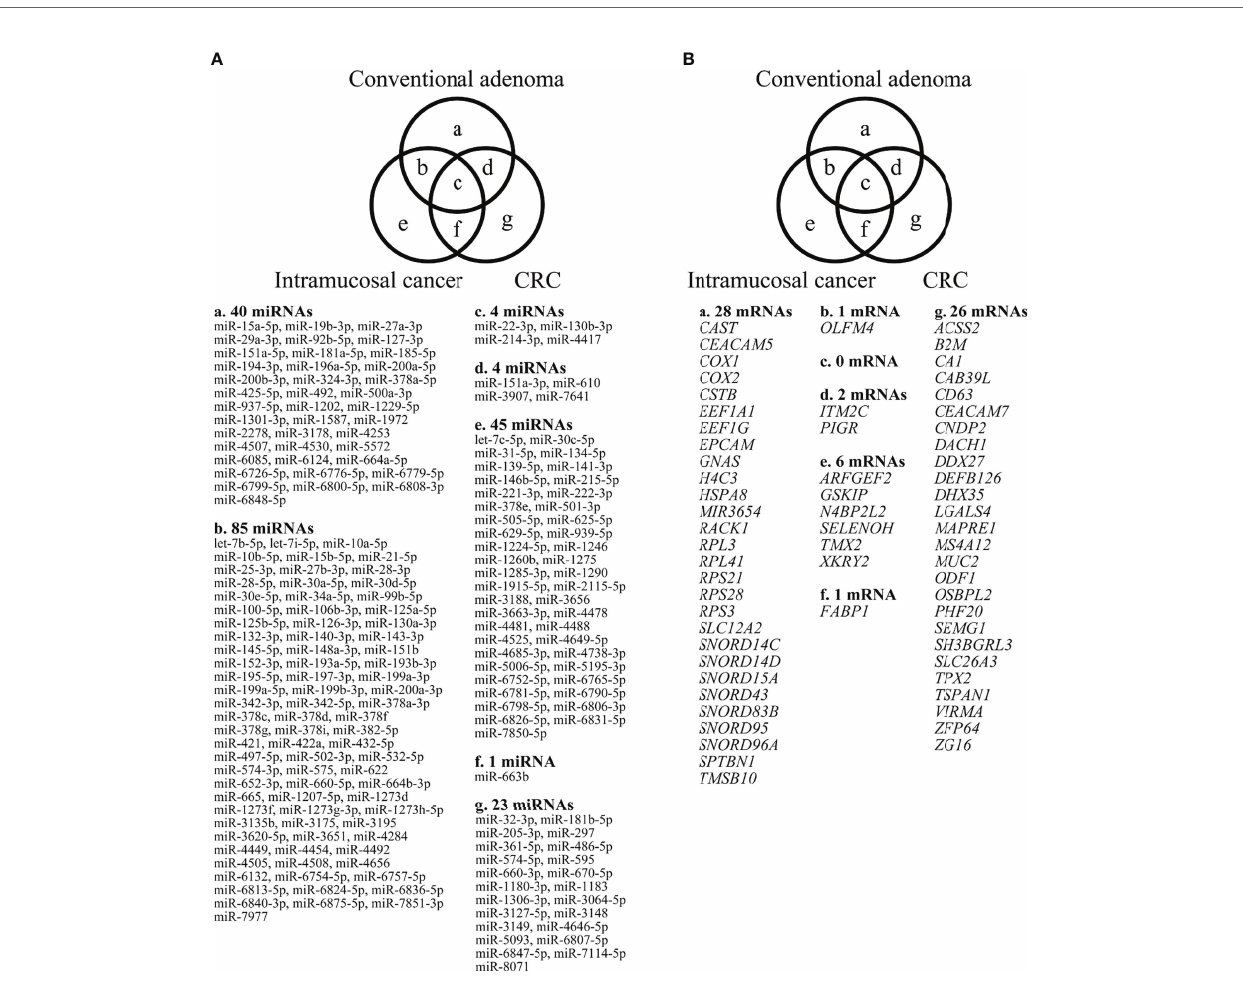
FIGURE 2 | Differential expression of miRNAs, comparing adenomas, IMCs, and CRCs having the MSS phenotype, as depicted by Venn diagram analysis. The numbers of miRNAs identi fi ed in adenomas, IMCs, and CRCs having the MSS phenotype were 40, 45 and 23, respectively. Among the three lesions, a considerable number of miRNAs overlapped with each other (adenoma and IMC, 85 miRNAs; adenoma and CRC with an MSS phenotype, 4 miRNAs; IMCs and CRCs having the MSS phenotype, 1 miRNA; adenomas, IMCs, and CRCs having the MSS phenotype, 4 miRNAs). 1-B. Differential expression of mRNAs between adenomas, IMCs, and CRCs having the MSS phenotype, as depicted by Venn diagram analysis. The numbers of mRNAs identi fi ed in adenomas, IMCs, and CRCs having the MSS phenotype were 28, 6, and 26. Among the three lesions, few mRNAs overlapped (adenoma and IMC, 1 mRNA; adenoma and CRC with an MSS phenotype, 2 mRNAs; IMCs and CRCs having the MSS phenotype, 1 mRNA; adenomas, IMCs, and CRCs having the MSS phenotype,